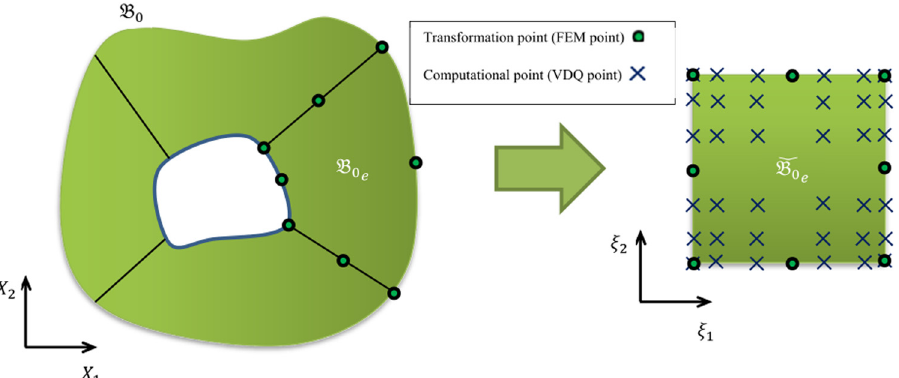
Figure 6: Mapping procedure of physical arbitrary shape domain into regular computational one in VDQ [ 110 ] ( where the X 2 , X 1 , ξ 2 , ξ 1 are the coordinates in the original coordinate system and the transformed coordinate system, the B e 0 is the space domain, and the B e 0  is the natural computational domain )